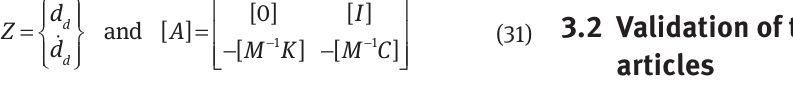
Table 1: The effect of the number of grid points on evaluating the convergence of natural frequency (GHz) of the FG cylindrical microshell with respect to different damping coefficients, boundary conditions (B.Cs) and L = 10 μ m, L/R = 10, h/R = 0.1, l